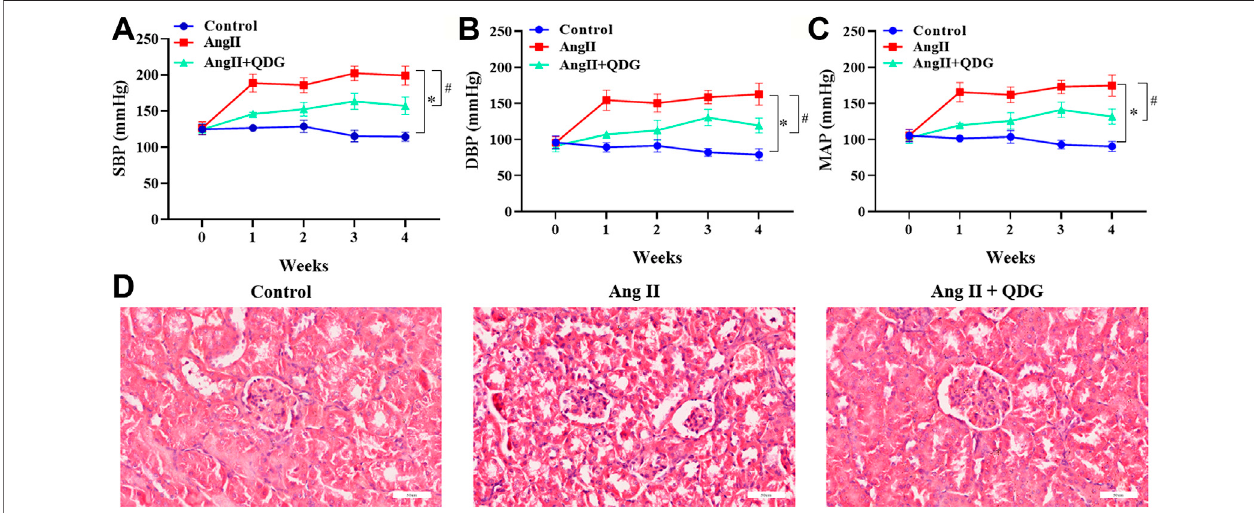
FIGURE 1| QDG attenuates Ang II-induced elevation of blood pressure and renal injury. (A) SBP, (B) DBP, and (C) MAP of mice from each group were monitored prior to the experiment and once a week for 4 weeks by using the CODA ™ noninvasive blood pressure system. (D) HE staining was performed to determine the pathological changes of renal tissues from each group. The representative images were taken at a magni fi cation of ×400 (scale bar 60 μ m). n = 5 for each group. Data were presented as mean ± SD; * p < 0.05 vs. the Control group, # p < 0.05 vs. the Ang II